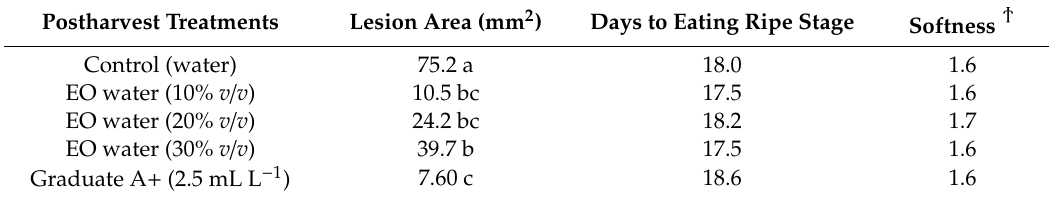
Table 3. E ff ect of electrolyzed oxidizing (EO) water and synthetic fungicide on anthracnose lesion area Table 2. Effect of electrolyzed oxidizing (EO) water and synthetic fungicides on postharvest diseases and ripening properties of avocado (cv. Hass) after inoculation with Colletotrichum siamense , Trial 2. and ripening properties of avocado cv. Hass, Trial Postharvest Treatments